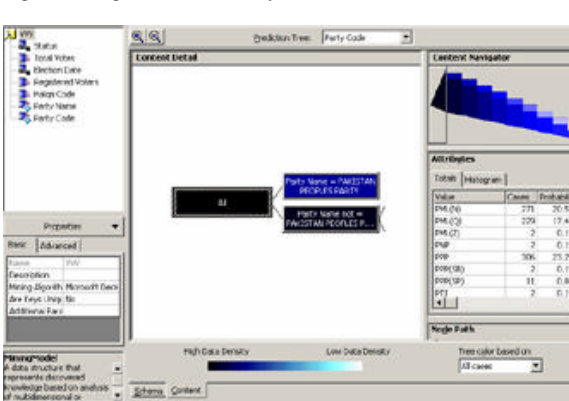
Fig 2: Histogram cases (Party wise data)